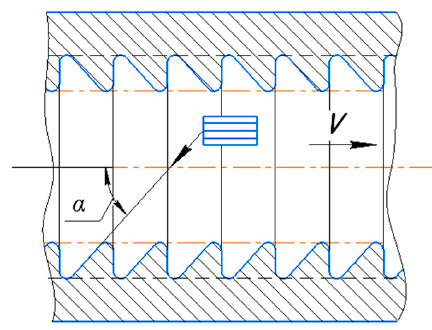
Figure 9. Location of the laser head nozzle in the pump cylinder.